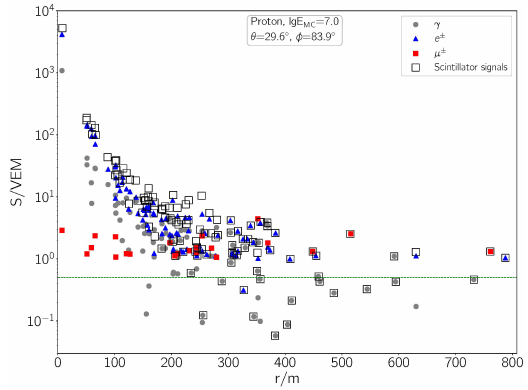
Figure 7. Lateral distribution of air-shower signals. The contri- butions from di ff erent particle species are shown in addition.